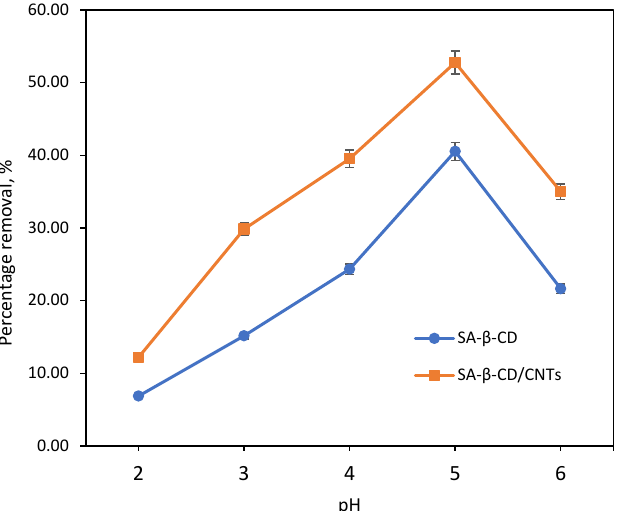
Figure 8. Effect of pH. Condition: [Ni(II)] = 10 mg/L, dosage = 1000 mg, contact time = 60 min.